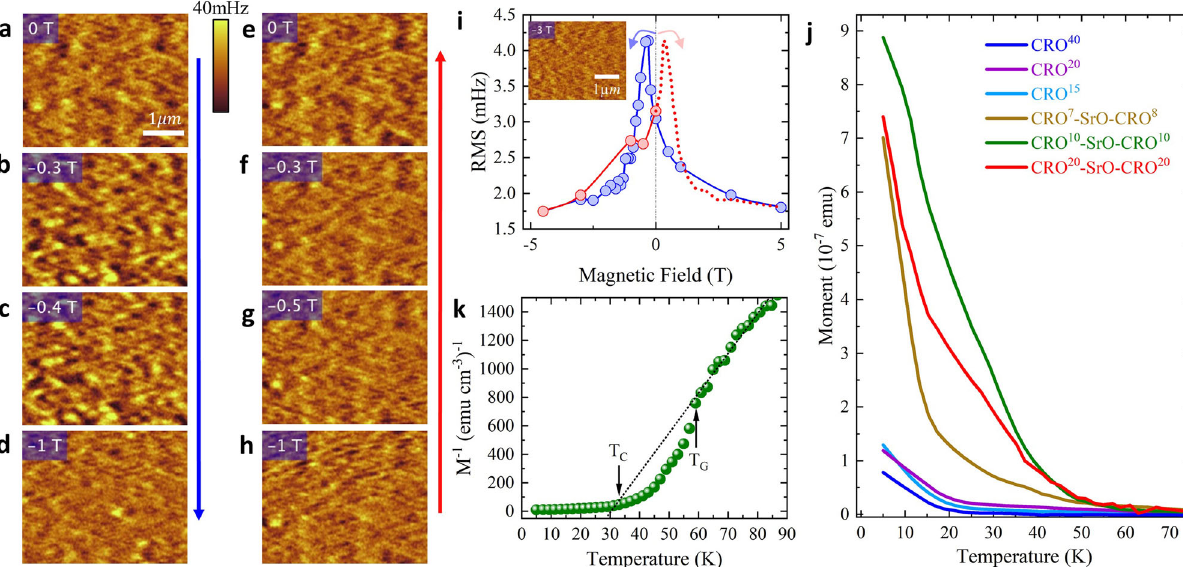
Fig. 4 Magnetic force microscopy (MFM) images of the δ -doped CRO 10 -SrO-CRO 10 heterostructure. The MFM images are taken in the increasing a – d and decreasing fi eld e – h process (indicated by arrows). i Field-dependent root-mean-square (RMS) data. The inset in i is the MFM image of the same area measured at − 3 T displaying a typical saturated state. j Temperature-dependent magnetization of different thickness of undoped and δ -doped CRO fi lms. k CRO 10 -SrO-CRO 10 magnetization (M) inverse as a function of temperature. The black dotted line in k indicates a guide for the linear fi